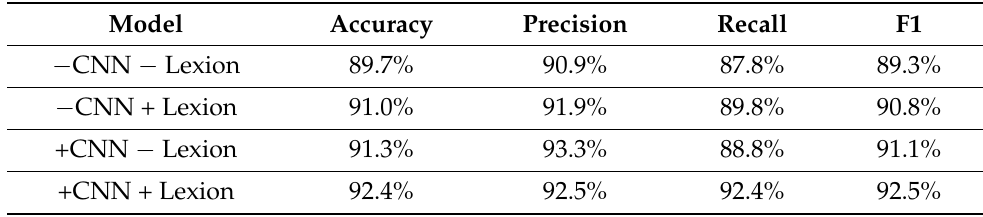
Table 7. Comparison model experiment